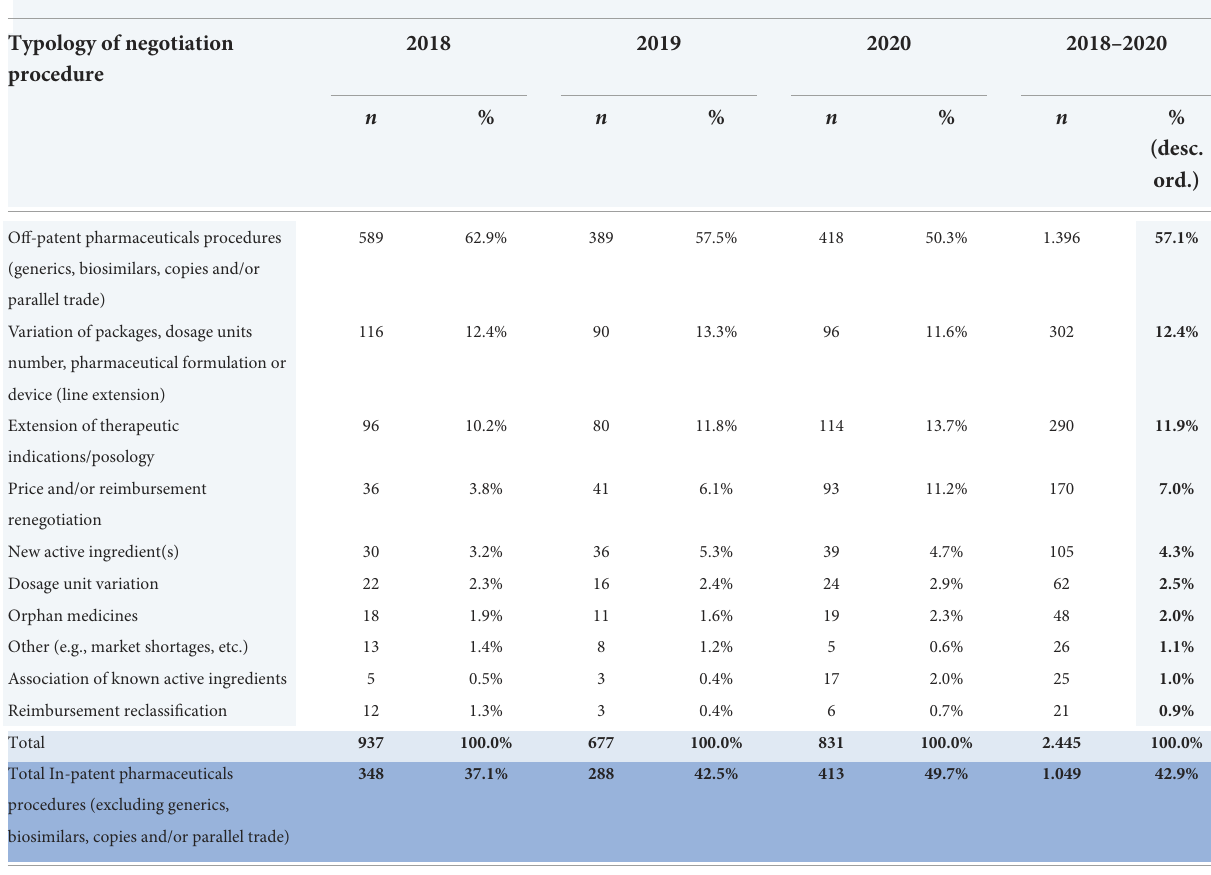
TABLE 1 Distribution of procedures by year and typology of the negotiation procedure. Typology of negotiation procedure, per year (frequency n , and %) Typology of